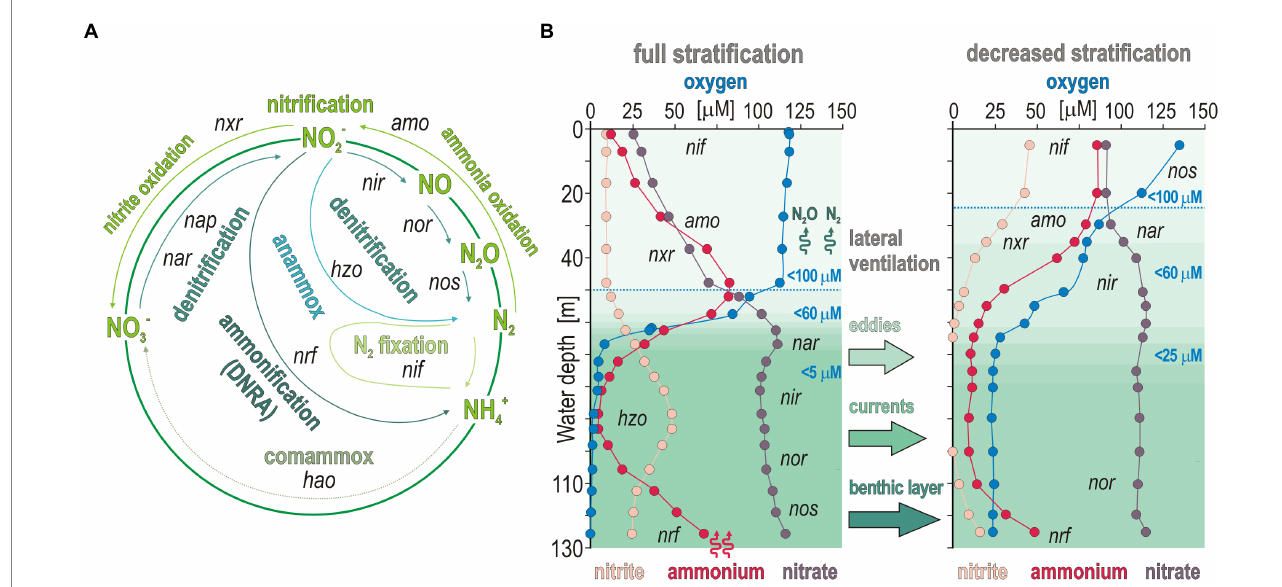
FIGURE 8 Pathways of nitrogen cycling with the corresponding functional marker genes, and theoretical biogeochemical gradients expected during full and partial stratification in coastal waters. (A) Nitrogen cycling functional genes related to processes of nitrogen fixation ( nif ), nitrification ( amo and nxr ), anaerobic ammonia oxidation, or anammox ( hzo ), dissimilatory nitrate reduction to ammonium (DNRA, nrf ), and denitrification ( nar , nap , nir , nor , and nos ). (B) Theoretical biogeochemical gradients expected during full (left) and decreased (right) stratification. Abbreviations: nif : nitrogen fixation/ amo : ammonium monooxygenase/ nxr : nitrite oxidoreductase/ hzo : hydrazine oxidoreductase/ nrf : ammonia-forming cytochrome nitrite reductase/ nar : respiratory nitrate reductase/ nap : periplasmic nitrate reductase/ nir : copper-containing nitrite reductase/ nor : nitric oxide reductase/ nos : nitrous oxide reductase/ hao : hydroxylamine